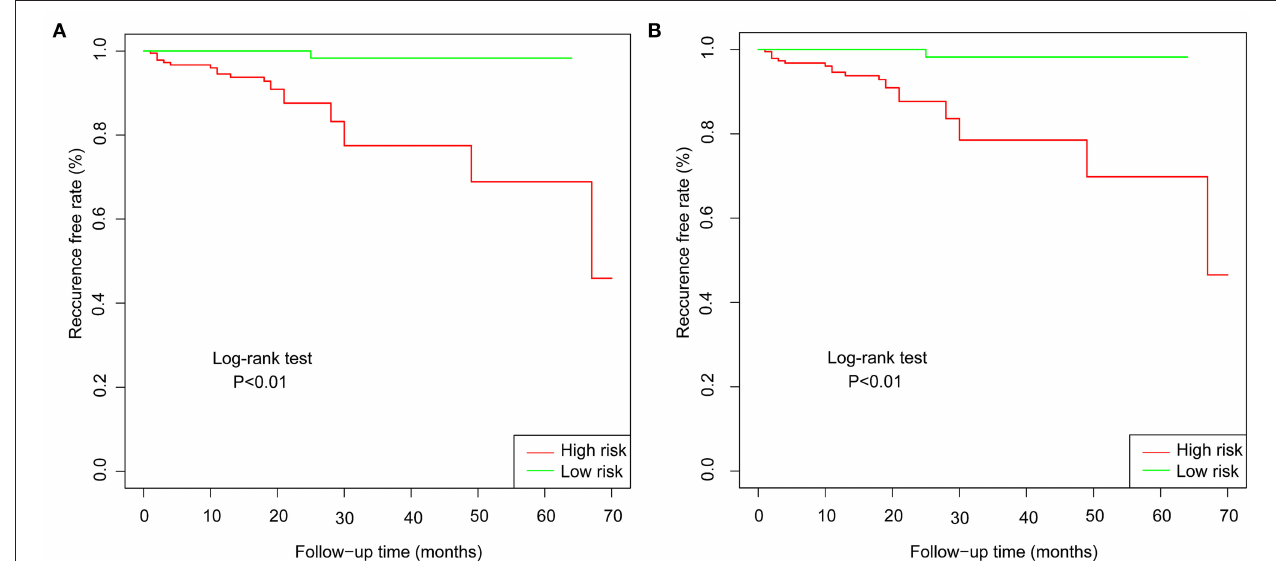
FIGURE 5 | (A) Kaplan-Meier curves for low-risk and high-risk populations stratified by nomogram 1 in the training set. (B) Kaplan-Meier curves for low-risk and high-risk populations stratified by nomogram 2 in the training